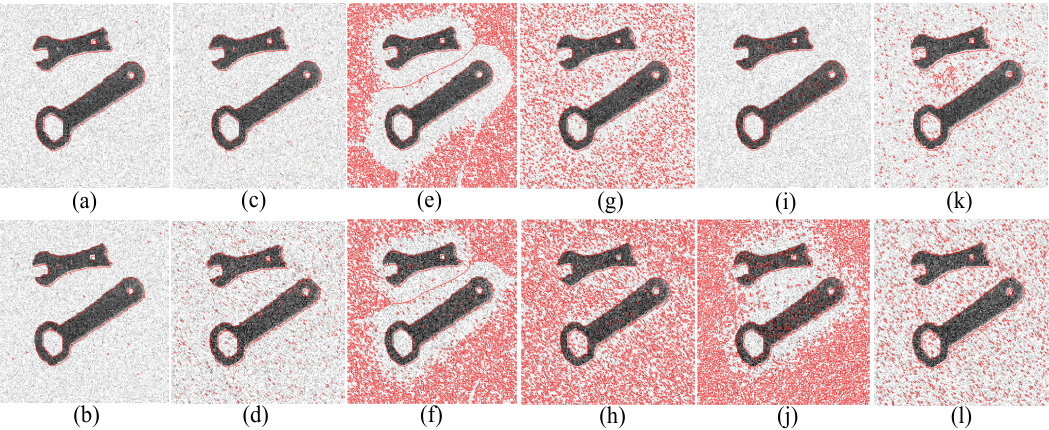
Figure 3. Segmentation results after adding noise. ( a ) The result of adding noise with variance of 0.01 to our model; ( b ) the result of adding noise with variance of 0.02 to our model; ( c ) the results of adding noise with variance of 0.01 to LIC model; ( d ) the results of adding noise with variance of 0.02 to LIC model; ( e ) the results of adding noise with variance of 0.01 to LBF model; ( f ) the results of adding noise with variance of 0.02 to LBF model; ( g ) the results of adding noise with variance of 0.01 to 0.5-order; ( h ) the results of adding noise with variance of 0.02 to 0.5-order; ( i ) the results of adding noise with variance of 0.01 to 1.5-order; ( j ) the results of adding noise with variance of 0.02 to 1.5-order; ( k ) the results of adding noise with variance of 0.01 to CV model; and ( l ) the results of adding noise with variance of 0.02 to CV model.